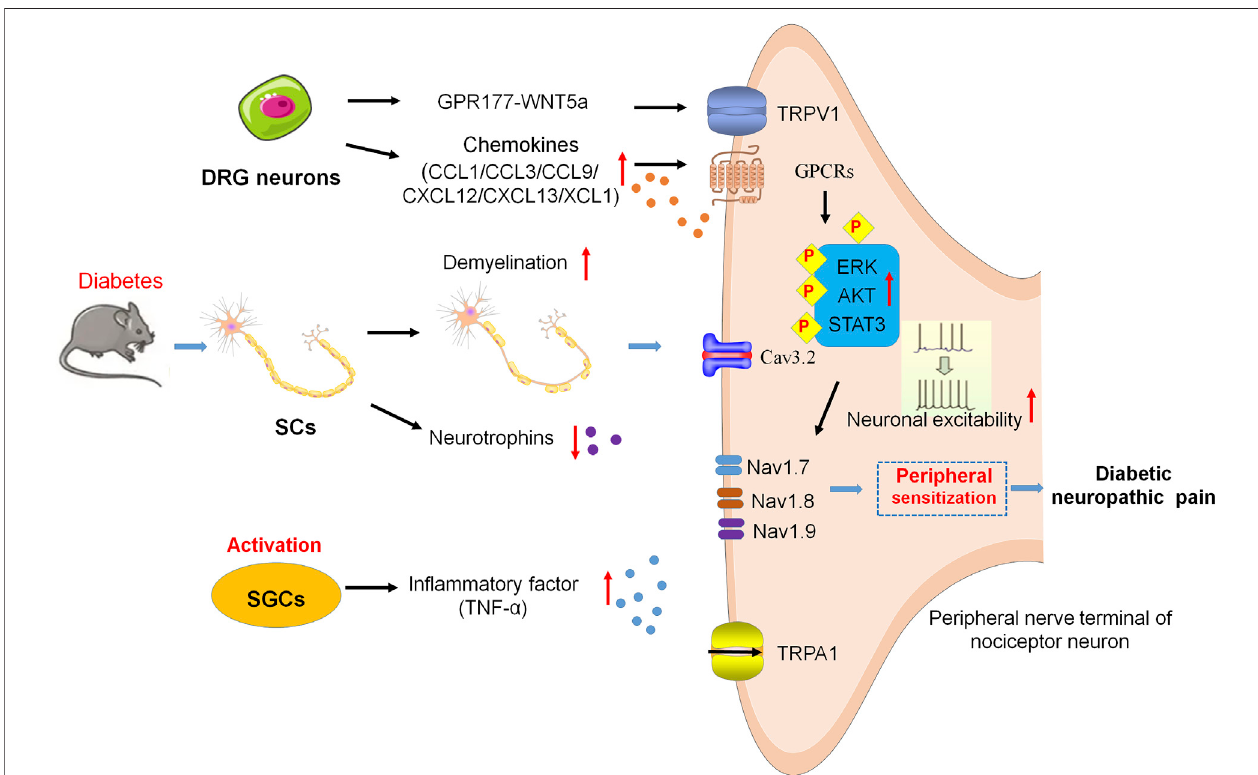
FIGURE 1 | Neuroin fl ammation and peripheral sensitization in DNP. SCs are damaged and decrease neurotrophin expression, resulting in demyelination of axons and failure of nerve regeneration. SGCs release TNF- α and then enhance the excitability of peripheral nociceptive neurons. Cav3.2 activity results in hyperexcitability of DRGneuronsviatheglycosylationofextracellulararginineresiduesindiabetes.Chemokinesactivatethesignalingcascades,suchasERK,AKT,andSTAT3,tosensitize the Nav1.7, Nav1.8, Nav1.9, and TRPA1, leading to hypersensitivity and hyperexcitability of peripheral nociceptive neurons. In addition, GPR177 derives DNP via WNT5a/TRPV1 interaction.